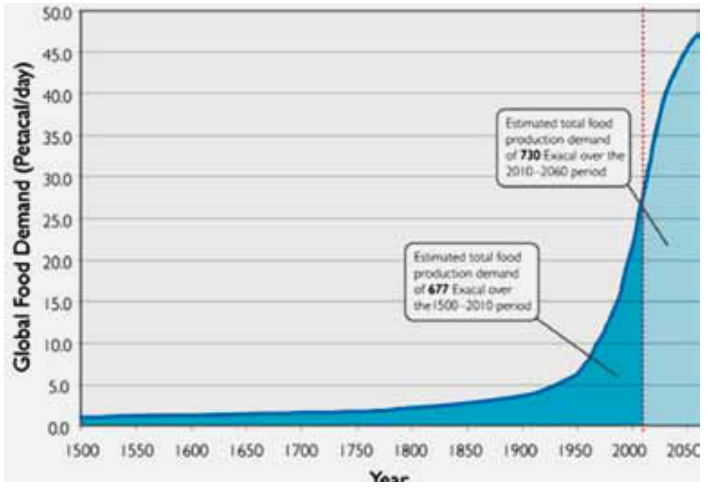
Figure 1: The challenge to produce enough food will be greater over the next 50 years then in all human history (source: Cribb,